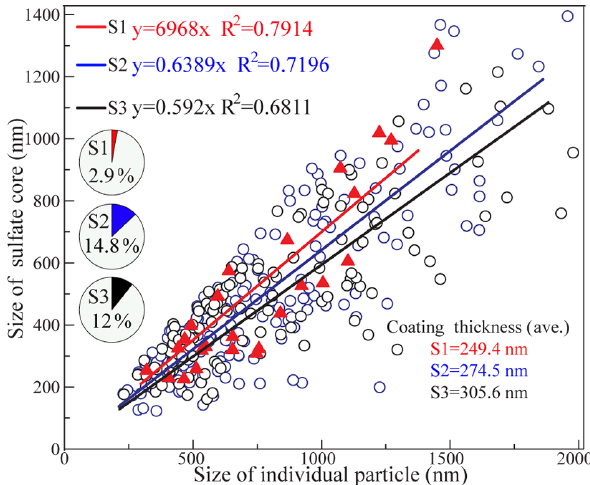
Figure 9. The relationship between the size of individual parti- cles and their sulfate cores based on 366 OM-coating particles at sites S1, S3, and S3. The smaller slope represents the thicker OM coating. The number fractions of OM coating particles to OM- containing particles at three sampling sites are shown in the pie